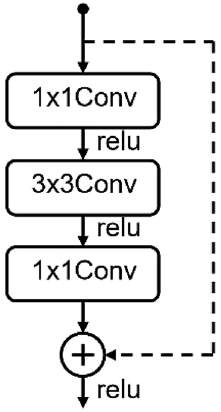
Figure 2. Residual